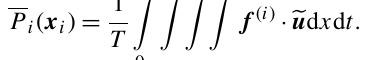
Figure 1. Snapshot of an instantaneous velocity field in the precur- sor domain and main simulation domain obtained from SP-Wind. Left panels: precursor, with side view (top) and plan view (bottom). Right panels: main, with side view (top) and plan view (bottom). Wind-farm area (cid:127) is shown in the green dashed box, and the fringe region with the green dash-dot